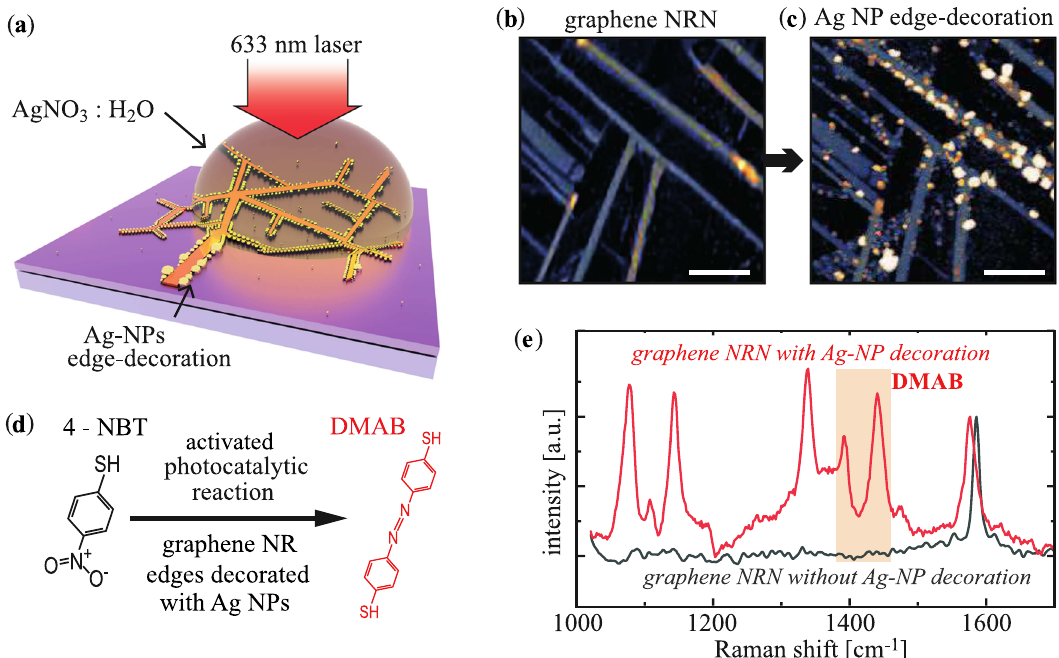
Fig. 6 Decoration of nanoribbon edges. a Illustration of the process for the decoration of the NRNs with metallic nanoparticles, and ( b , c ) graphene NRN before and after edge-decoration with Ag NPs (scale bars 500 nm, z-scales 25 nm). d Dimerization of 4-NBT to DMAB and ( e ) demonstration of the photocatalytic activity and (surface-enhanced raman spectroscopy) SERS capability of the hybrid graphene-NRN + Ag-NP